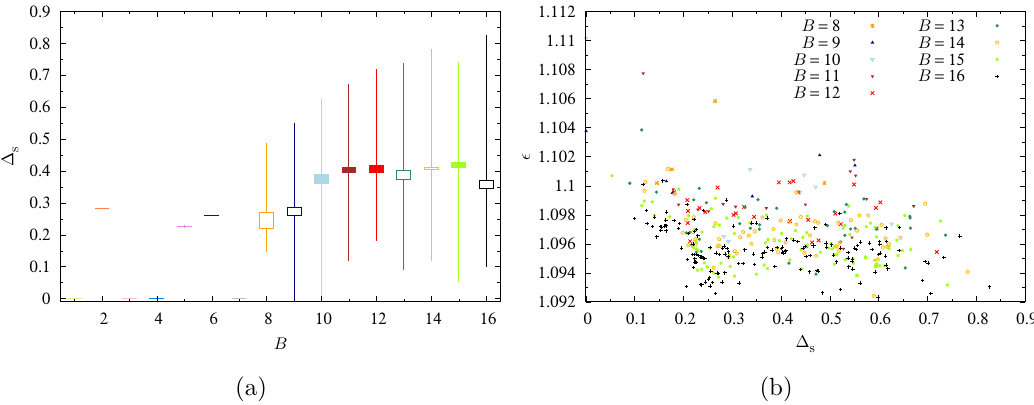
Figure 15. (a) Sphericity ∆ s of the Skyrmions: the mean and median as a box with the lines representing the spread. (b) Sphericity ∆ s of the B = 8 through 16 solutions versus normalized energies (cid:15)